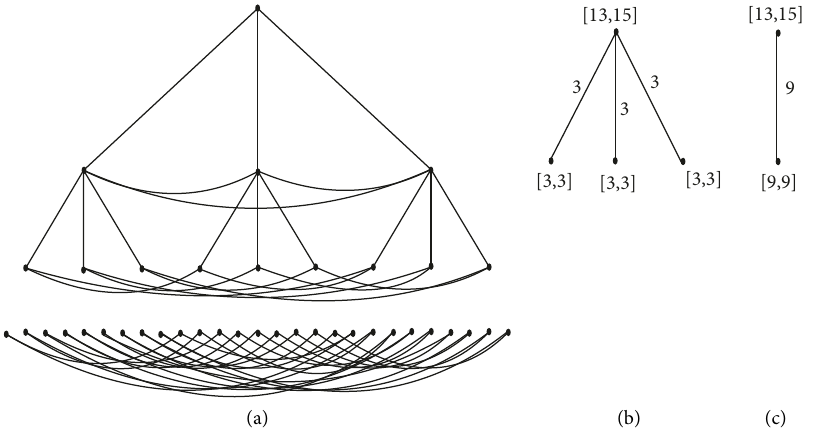
Figure 3: (a) THT ( 4 ) / F